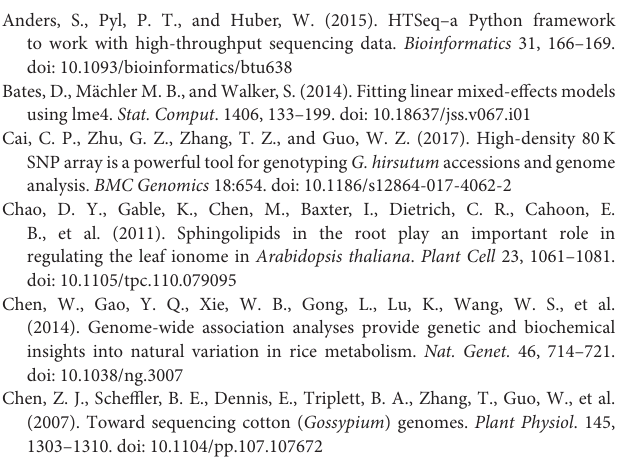
Supplementary Table 6 | GO analysis of genes in candidate QTL intervals related to fiber length (FL), fiber strength (FS), and fiber micronaire (Mic). Supplementary Figure 1 | Correlation analysis of fiber length from different environments. The number in these boxes indicated correlation coefficient (R value). ∗∗∗ indicated P value at the 0.001 levels. Supplementary Figure 2 | Correlation analysis of fiber strength from different environments. The number in these boxes indicated correlation coefficient (R value). ∗ indicated P value at the.05 levels, ∗∗ indicated P value at the 0.01 levels, ∗∗∗ indicated P value at the 0.001 levels. Supplementary Figure 3 | Correlation analysis of fiber micronaire from different environments. The number in these boxes indicated correlation coefficient (R value). ∗ indicated P value at the 0.05 levels, ∗∗ indicated P value at the 0.01 levels, ∗∗∗ indicated P value at the 0.001 levels. Supplementary Figure 4 | Density distribution map of 56010 high-quality SNPs in 26 chromosomes. Supplementary Figure 5 | Venn diagram of QTLs associated with fiber length (FL), fiber strength (FS), and fiber micronaire (Mic). Supplementary Figure 6 | Manhattan plot of FL on Chr. D11. Black dashed line represents the significance threshold (LOD score = 3). Pink dot indicates the position of TM77015. Supplementary Figure 7 | Manhattan plot of Mic on Chr. A05. Black dashed line represents the significance threshold (LOD score = 3). Pink dot indicates the position of